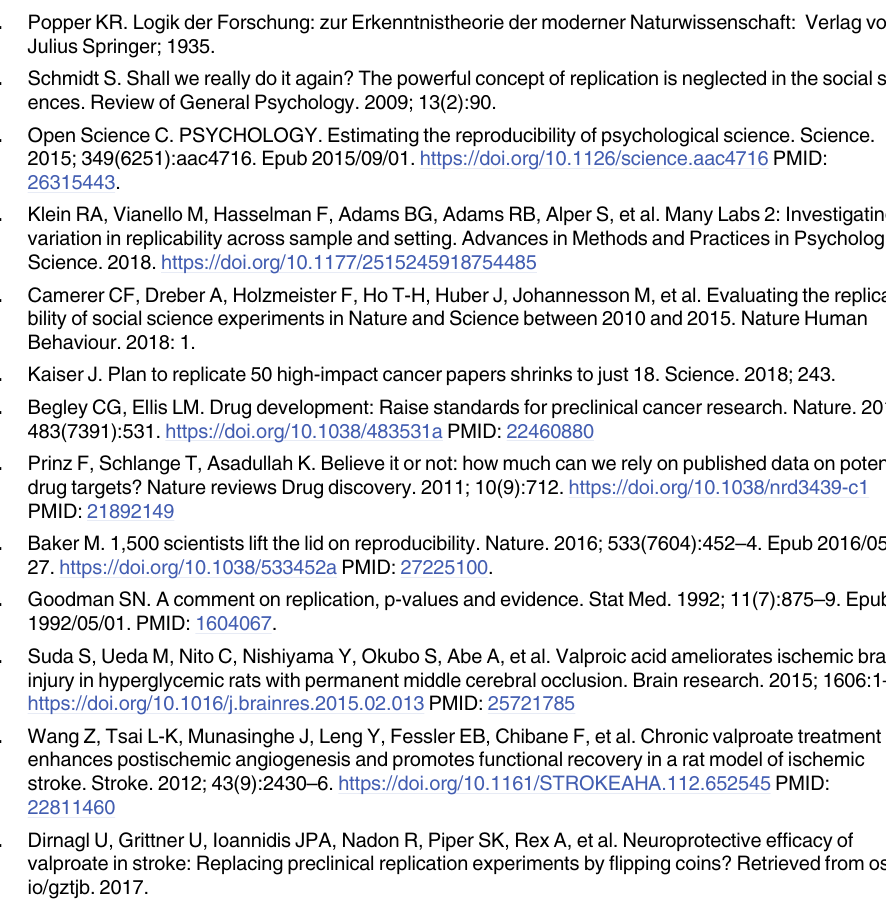
S1 Fig. Results of the original experiment. Brain infarct volumes with and without treatment of VPA. N = 10 per group. Box plots represent median, 25th and 75th percentile, mean (dotted line), 5th and 95th percentile (whiskers) and, additionally, the individual data points that are also given in S1 Data. S1 Data. Data for Fig 1 and S1 Fig. (XLSX) S1 Text. Methods original and ‘replication’ experiment.